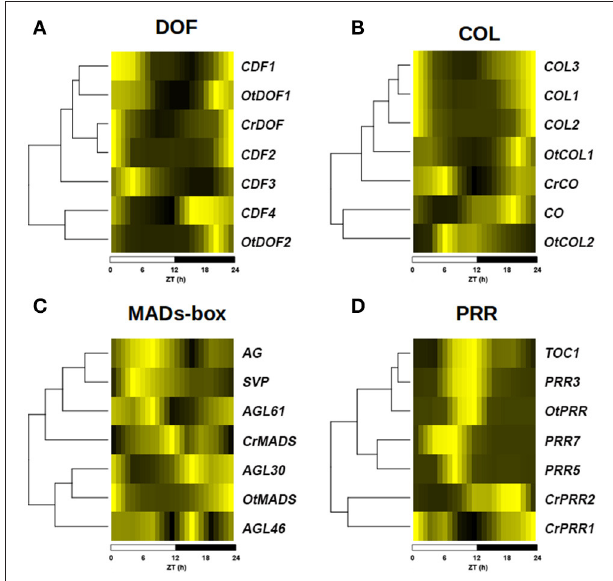
FIGURE 5 | Diversification of expression profiles after gene amplification. Heat plots showing the diversification in the expression profiles of the different members of TF gene families from figure 4 in a ND photoperiod. A color scale from deep yellow (maximum expression) to black (minimal expression) is used. Hierarchical clustering is used to sort genes according to the similarity between their expression profiles. (A) Expression profile of DOF gene family. (B) Expression profile of COL gene family. (C) Expression profile of MADS -box gene family. (D) Expression profile of PRR gene family. Notice that while some Arabidopsis genes have retained similar expression patterns as Ostreococcus and Chlamydomonas genes, others have acquired completely new expression profiles. Below each graphic, a time scale in Zeitgeber Time (ZT) in hours (h) is